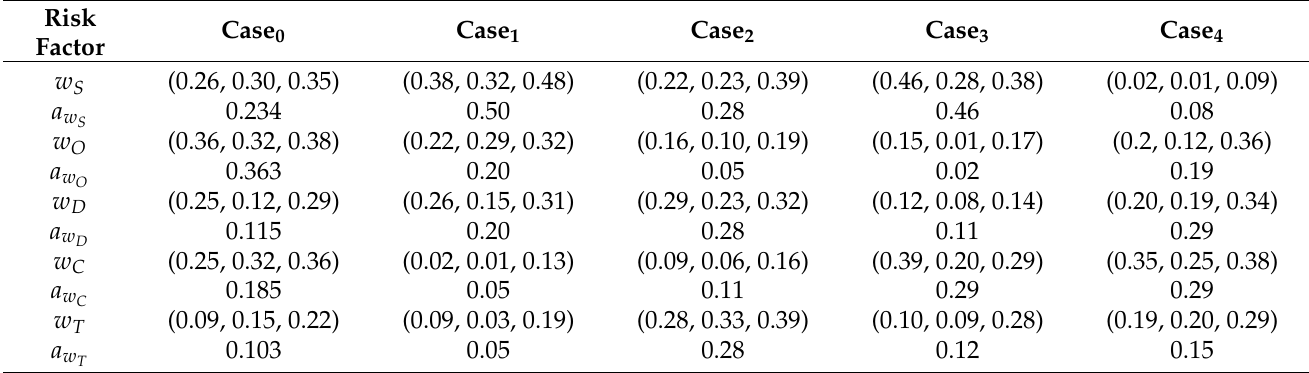
Table 20. Weights and crisp value of weights of SODCT factors in different cases.